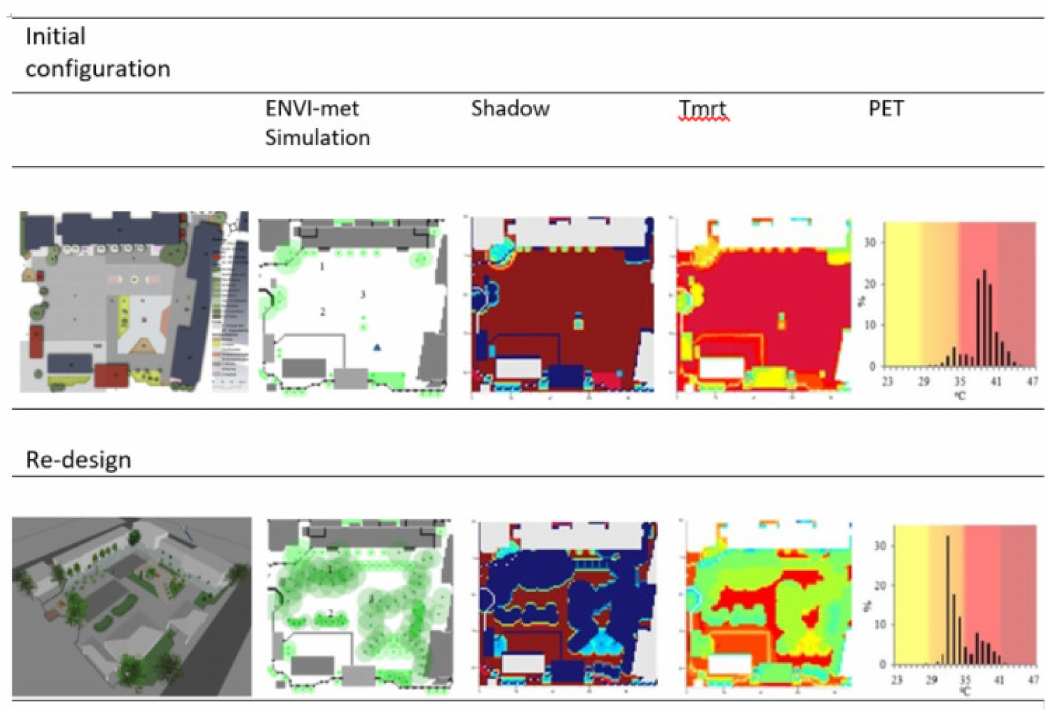
Figure 4. Application of the microclimate mode ENVI-met (V4) for the simulation of the e ff ects of redesign proposal at an urban schoolyard in Volos, Greece. Source [7].